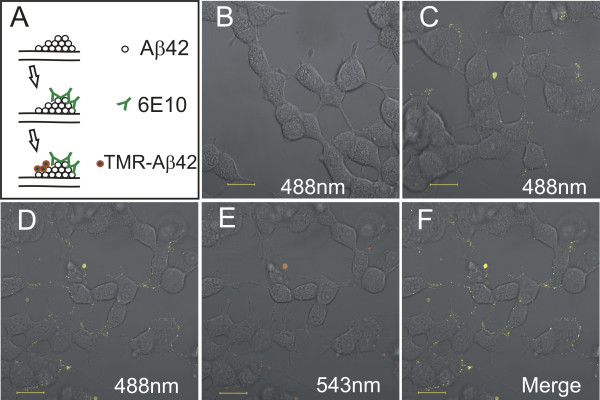
Cell surface aggregation of Aβ. All scale bars are 20 μm in length. (A) Schematic diagram indicating the order of cell surface treatments on NGF differentiated PC12 cells, separated by wash steps indicated by the arrows. (B) Confocal microscopy image of cells treated with 6E10 and secondary Alexa fluor 488 labelled antibody. The absence of staining in this control indicates the primary and secondary antibodies do not non-specifically bind to the cell surface. (C) Images of cells treated with 5 μM unlabelled Aβ42 followed by immunostaining with 6E10 and secondary Alexa fluor 488 labelled antibody. (D) Images of cells treated with 5 μM unlabelled Aβ42 followed by immunostaining, and treatment with 1.5 μM TMR-Aβ42 using 488 nm laser excitation. (E) Images of cells treated with 5 μM unlabelled Aβ42 followed by immunostaining, and treatment with 1.5 μM TMR-Aβ42 using 543 nm laser excitation. (F) Merge confocal microscopy image indicating regions of 6E10 antibody only in green, TMR-labelled Aβ42 in red and co-localized regions in yellow.